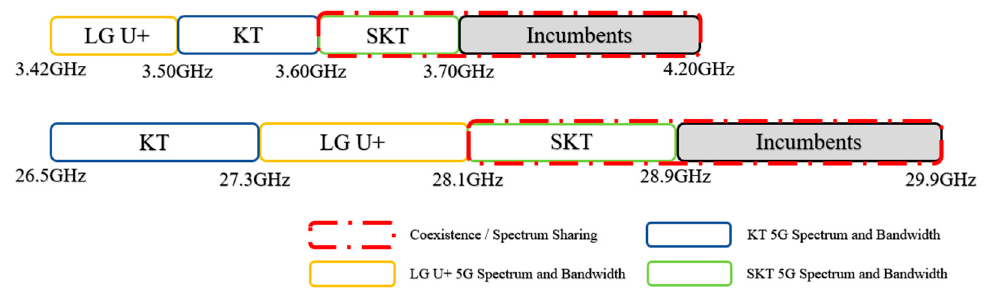
Figure 1. Korea’s 5G frequency allocations and their adjacent bands [1].